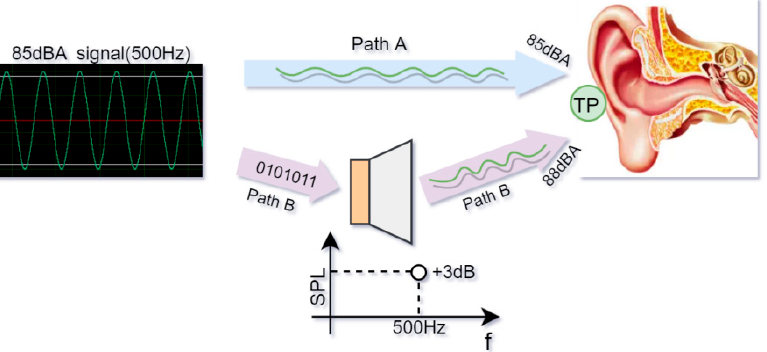
Figure 1. Sound-level deviation caused by the speaker makes dose estimation inaccurate. The speaker’s frequency response curve has a 3 dB deviation at frequency point 500